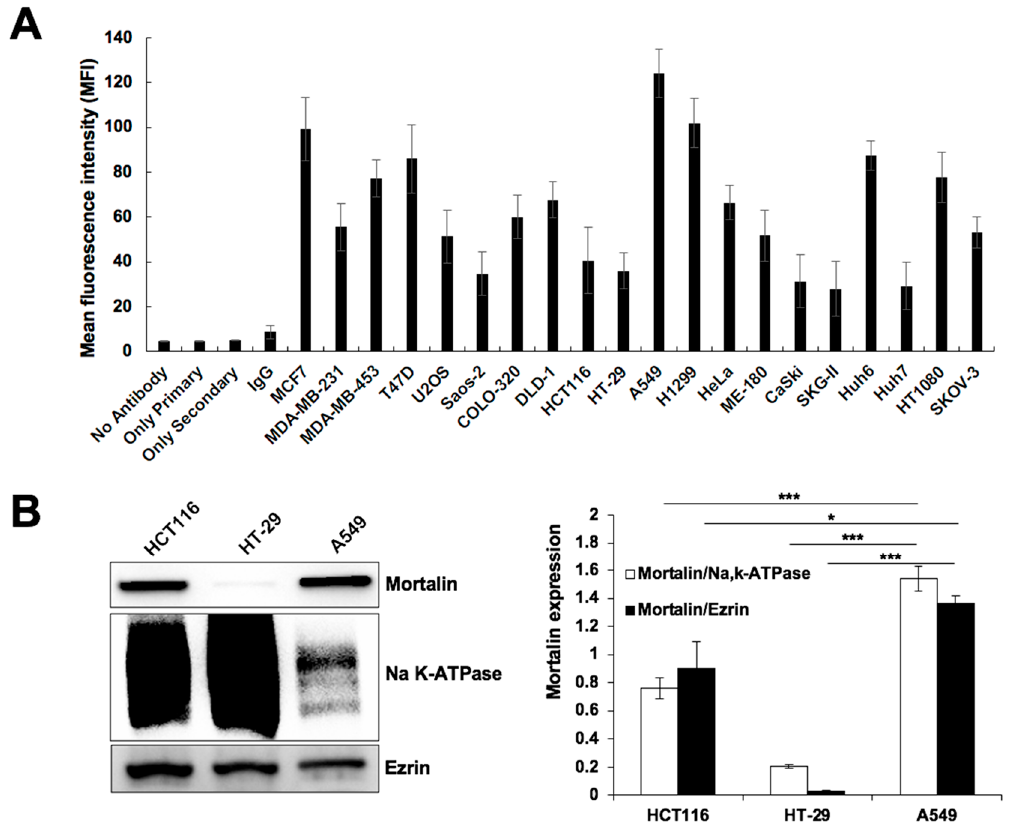
Figure 2. Cell surface expression of mortalin in different cancer cell lines. ( A ) Mean fluorescence intensity (MFI) of mortalin. FACS analysis showed cell surface expression, although to a variable extent, of mortalin in various cancer cells. Values are expressed as a median. ( B ) Western blotting for mortalin in the plasma membrane fractions of HCT116, HT-29, and A549 cells is shown; NaK-ATPase and Ezrin were used as the loading control and irrelevant membrane protein control, respectively. Quantitation data of Western blotting from three independent experiments is shown on the right (mean ± SD, n = 3), * p < 0.05, *** p < 0.001 (Student’s t-test).